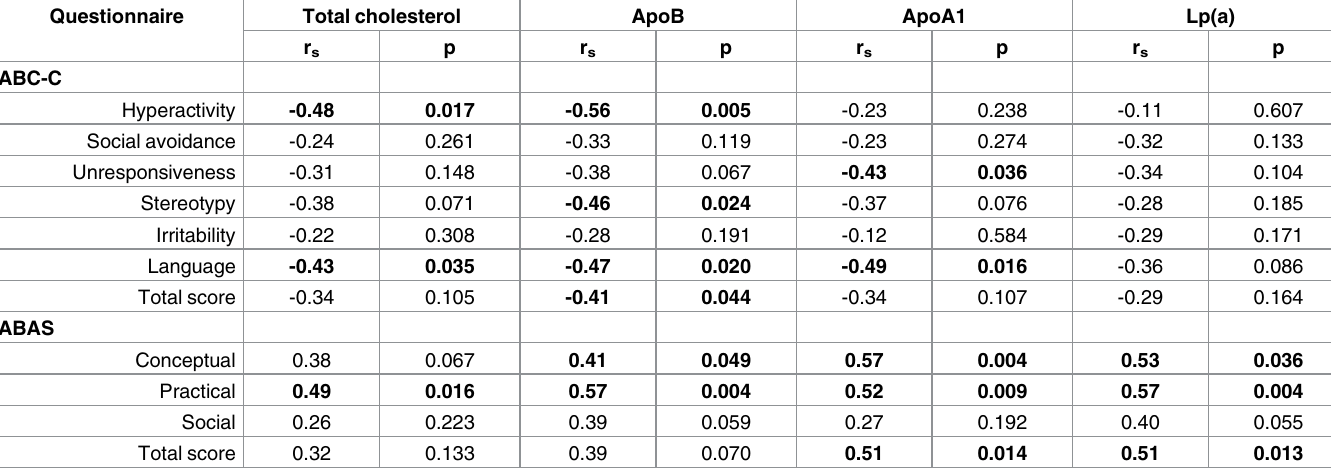
Table 3. Association of lipid parameters with cognitive